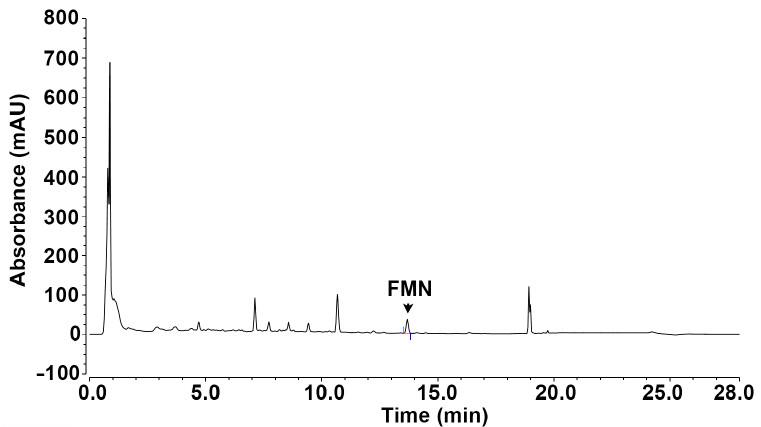
Figure 1. FMN identified in JRP-SNF102 by HPLC.